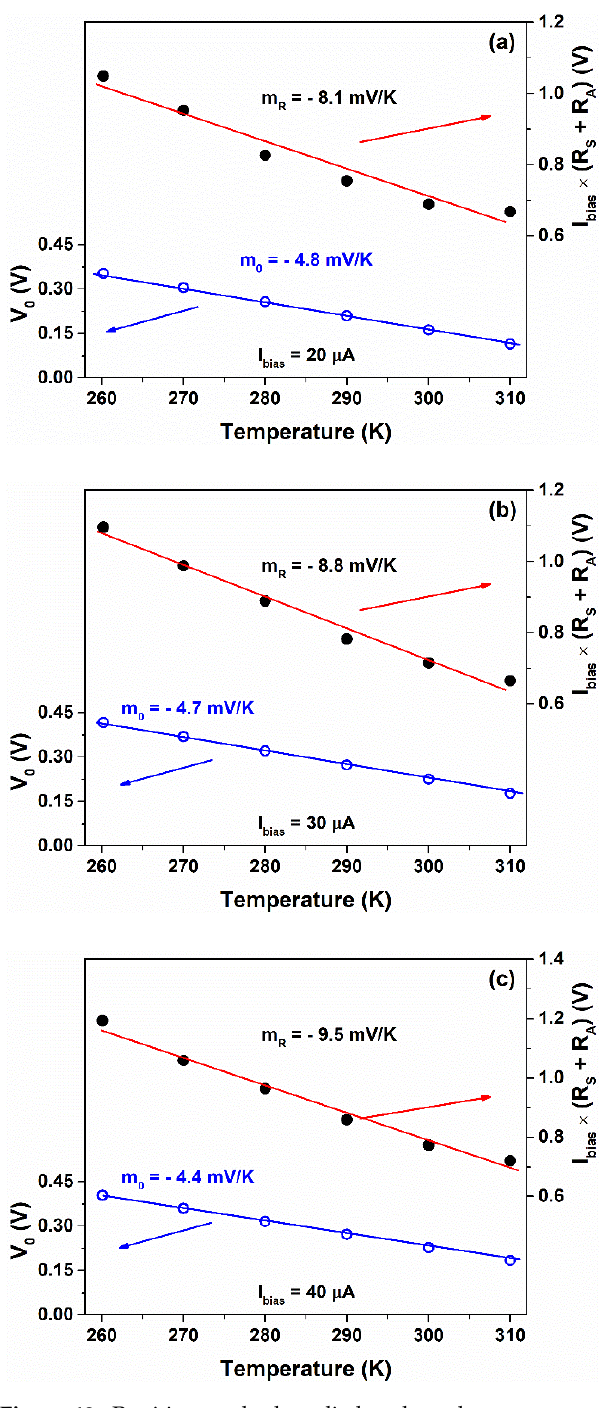
Figure 12. Partition method applied to the voltage measured across the sensor as a function of the temperature for bias current values of ( a ) 20 μ A, ( b ) 30 μ A and ( c ) 40 μ A, respectively. The red and blue solid lines represent the linear fit for the self-powered and current biased components, respectively.